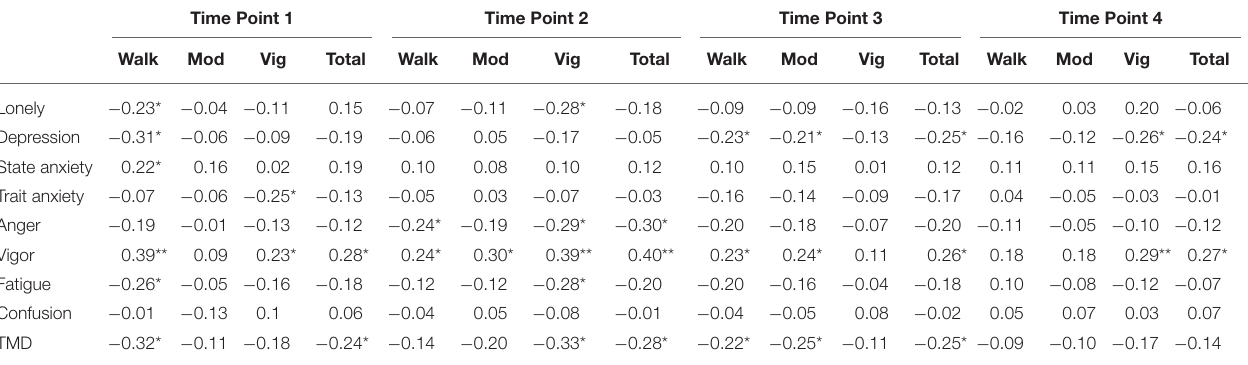
TABLE 3 | Pearson’s r Correlations examining the relationships between mental health outcomes and physical activity amount over four time points. Time Point 1